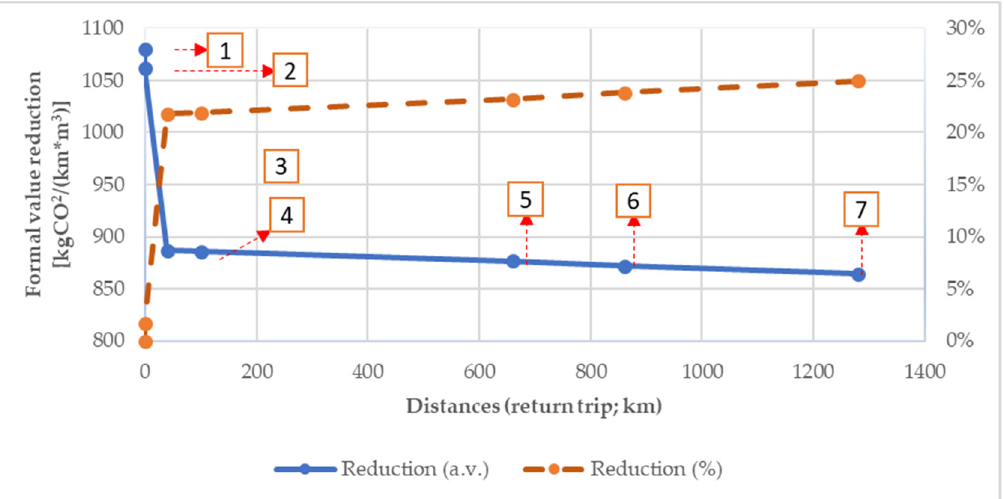
Figure 6. Reduction of Net ‐ CDS of chestnut wood by the distance to the markets (1 = forest; 2 = forest temporary repository; 3 = sawmill; 4 = market of Rome; 5 = market of Florence; 6 = market of Bologna; 7 = market of Trento).